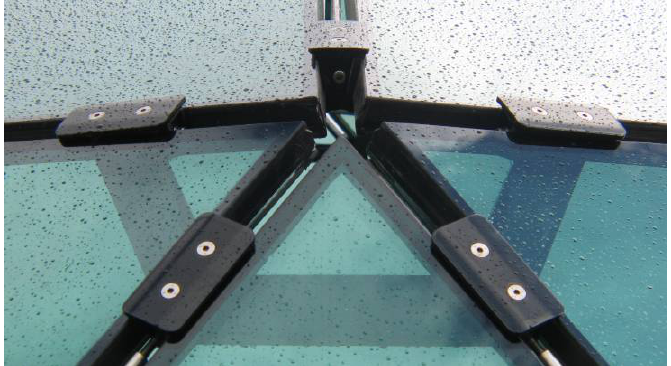
Figure 11: Crossing point of